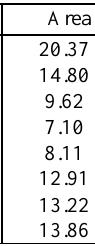
Table 9. Areal distribution (%) of the